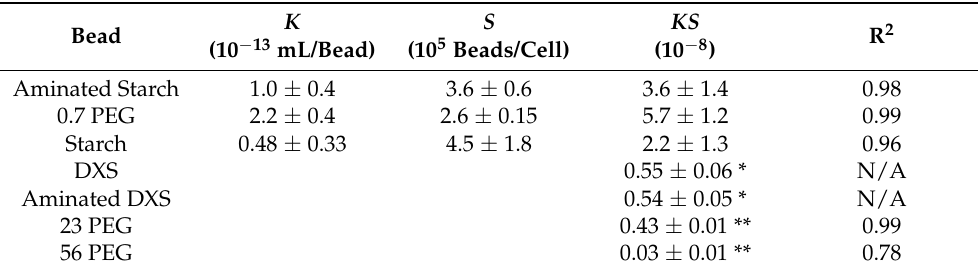
Figure 3. Beads per cell (y) after 24 h versus bead concentration (x). ( a ) Langmuir adsorption isotherms (equation shown) were fitted, and K and S values are listed in Table 2 for beads with different surfaces. KS represents initial slope. ( b ) KS versus PEG surface coating illustrating the 99.5% reduction in binding due to 56 nmole/mg Fe PEG coverage. Table 2. Langmuir adsorption isotherm constants for seven bead compositions. The product of K and S represents the initial slope, which could be determined directly for the low-adsorbing PEG-coated beads using y = KSx as x → 0.